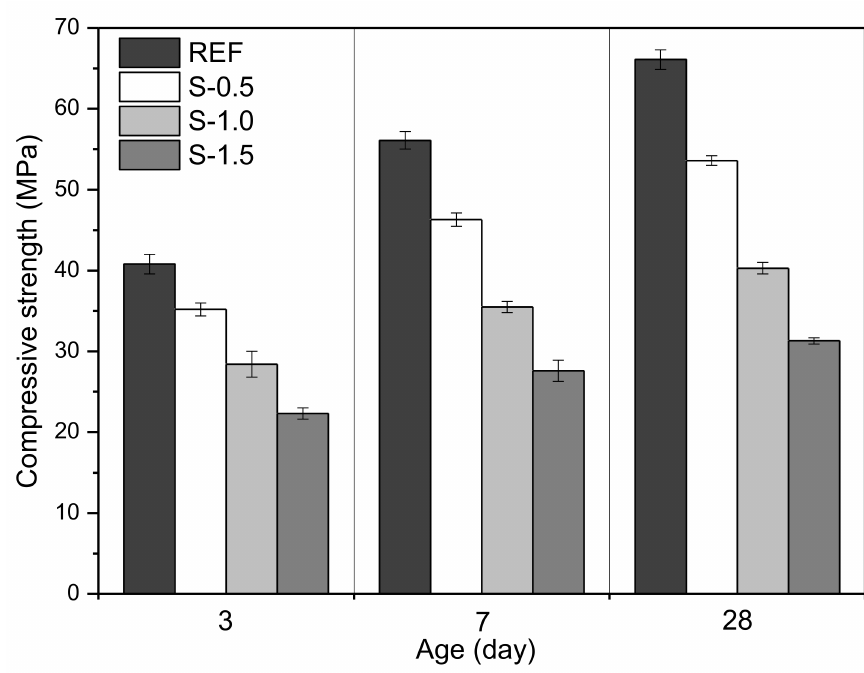
Figure 16. Compressive strength of specimens at 3, 7, and 28